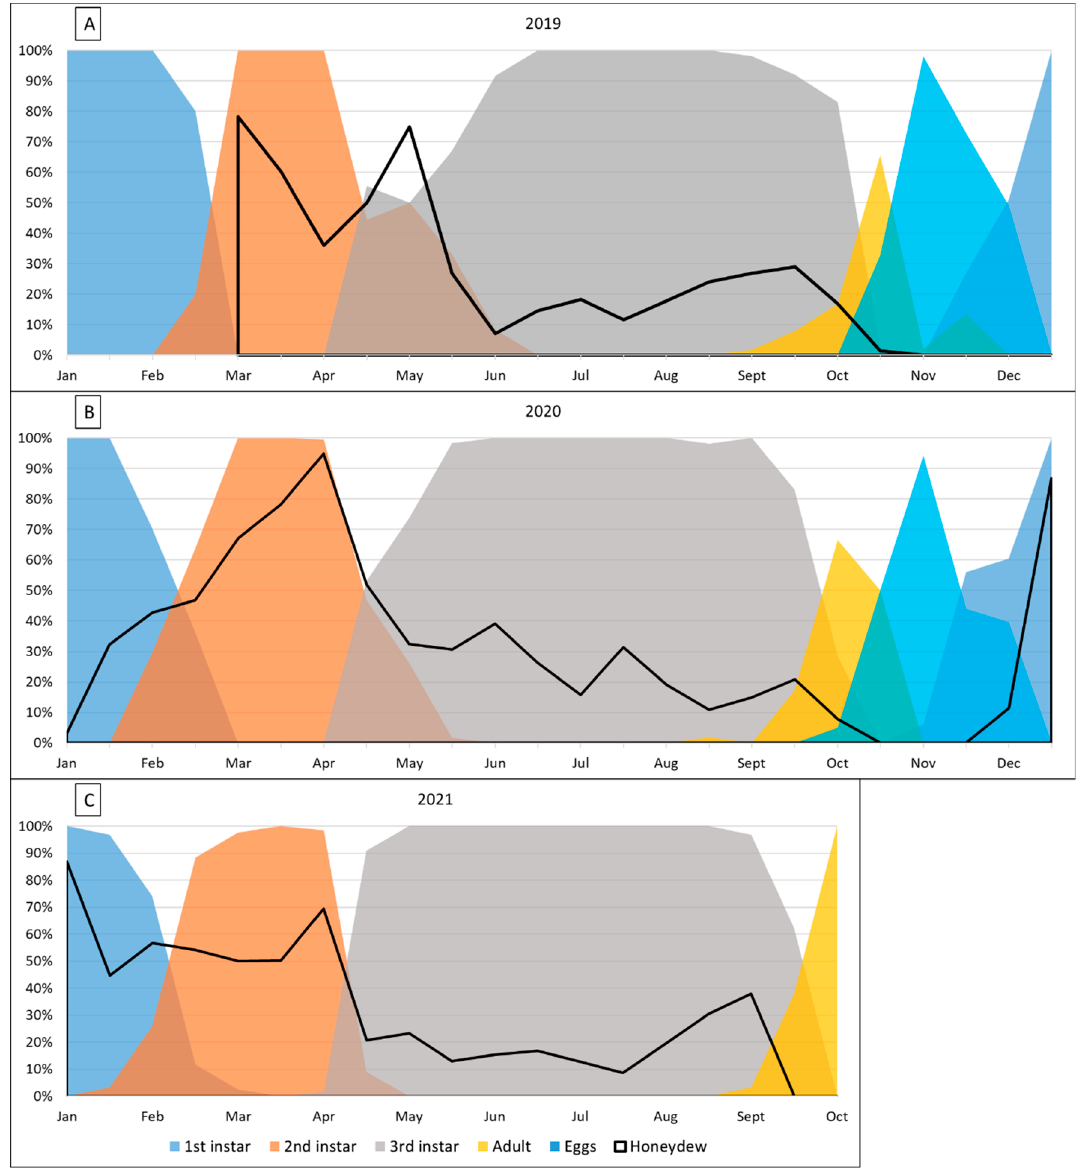
Figure 2. Phenology of Marchalina hellenica in Southeast Melbourne, showing the abundance of each life stages as a proportion of population in ( A ) 2019, ( B ) 2020, and ( C ) 2021, and the proportion of insects producing honeydew (black line).